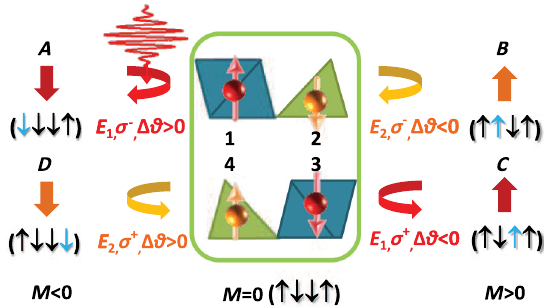
FIG. 1. Illustration of optomagnets created by optical helicities in a magnetic basis. Four distinct spin quantum states A , B , C , D can be selectively created from the zero-magnetization ( M ¼ 0 ) state by flipping one of the sublattice spin moments ð 1 ; 2 ; 3 ; 4 Þ ¼ ð ↑↓↓↑ Þ with the flipped moment color coded in each unique configuration. This optomagnet can be made possible through the on-site d - d optical transitions with combinations of pump photon energies E 1 and circularly polarized pumps σ (cid:2) . Combining the ; 2 resultant magneto-optical Kerr rotations Δ θ , we can unambigu- ously discern the four distinct microscopic states that lead to two switchable magnetization directions macroscopically.